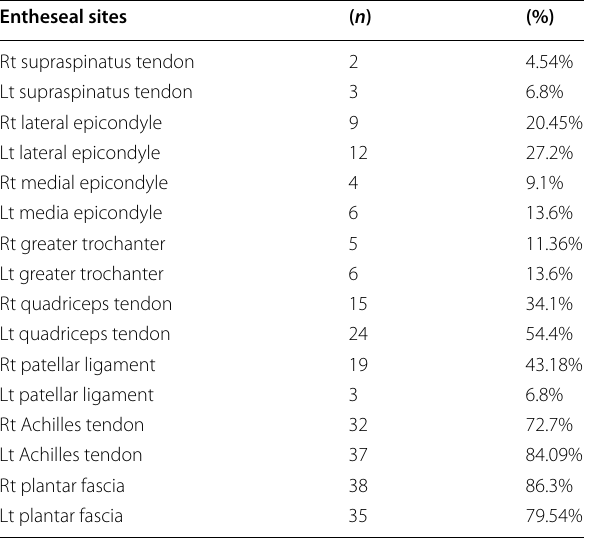
Table 4 Numbers and percentages of entheseal sites involved in the psoriatic arthritis patients with enthesitis according to